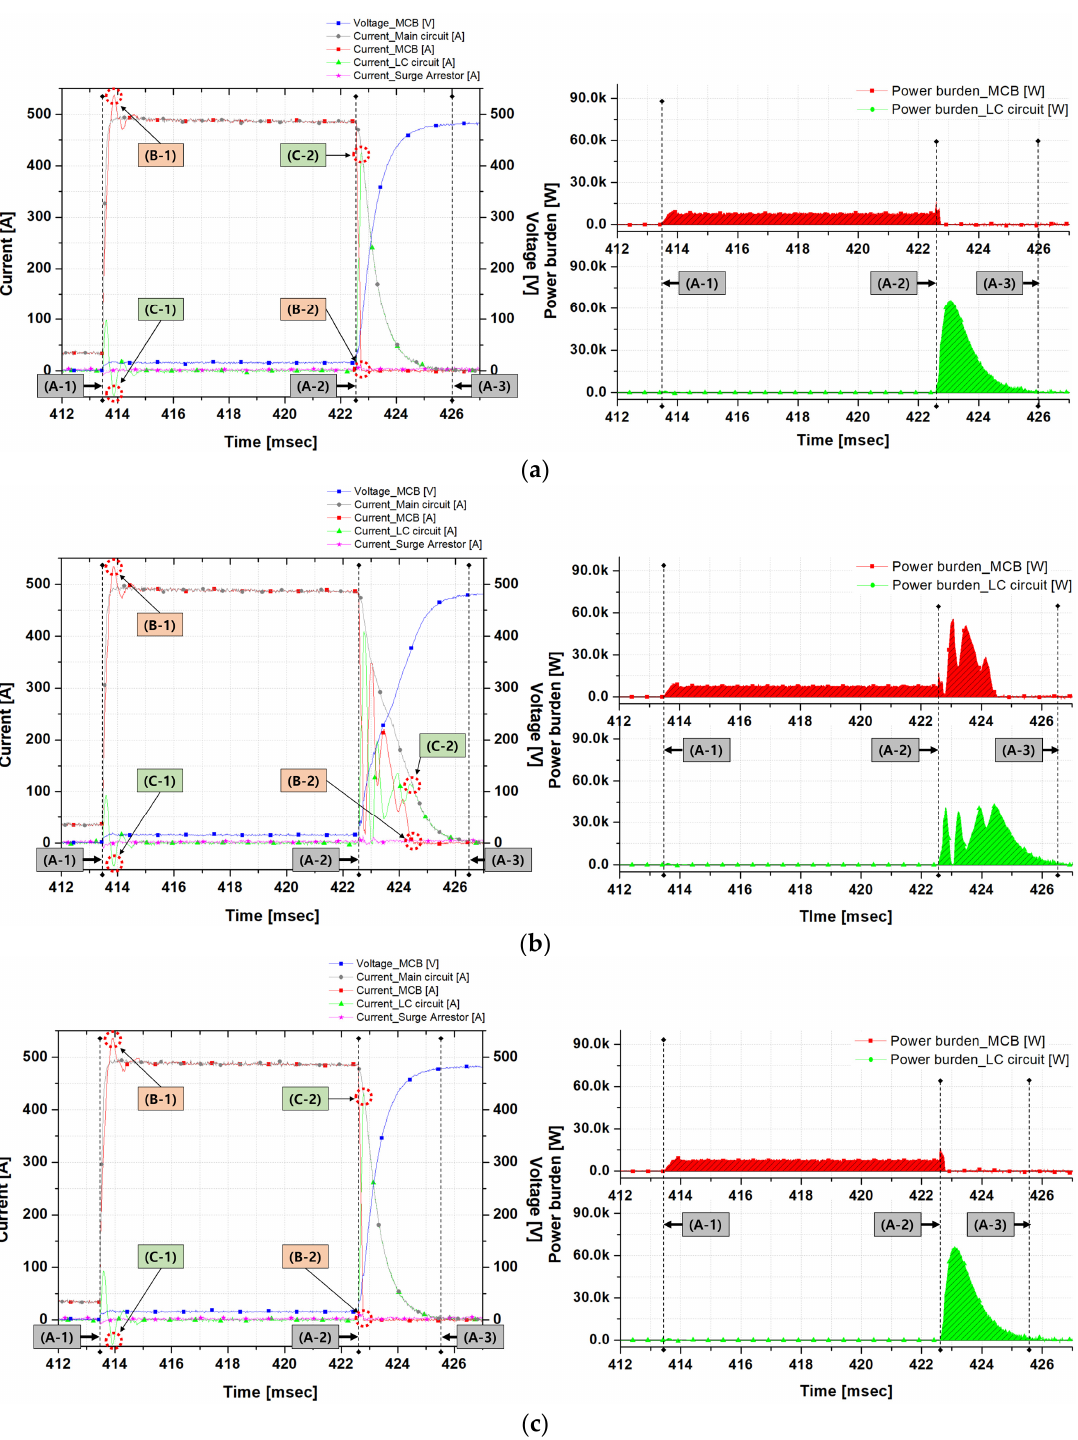
Figure 5. Operational characteristics analysis graph of DC circuit breaker to which the Reactor variable is applied ( a ) 5 μH , ( b ) 15 μH , ( c ) 25 μH .